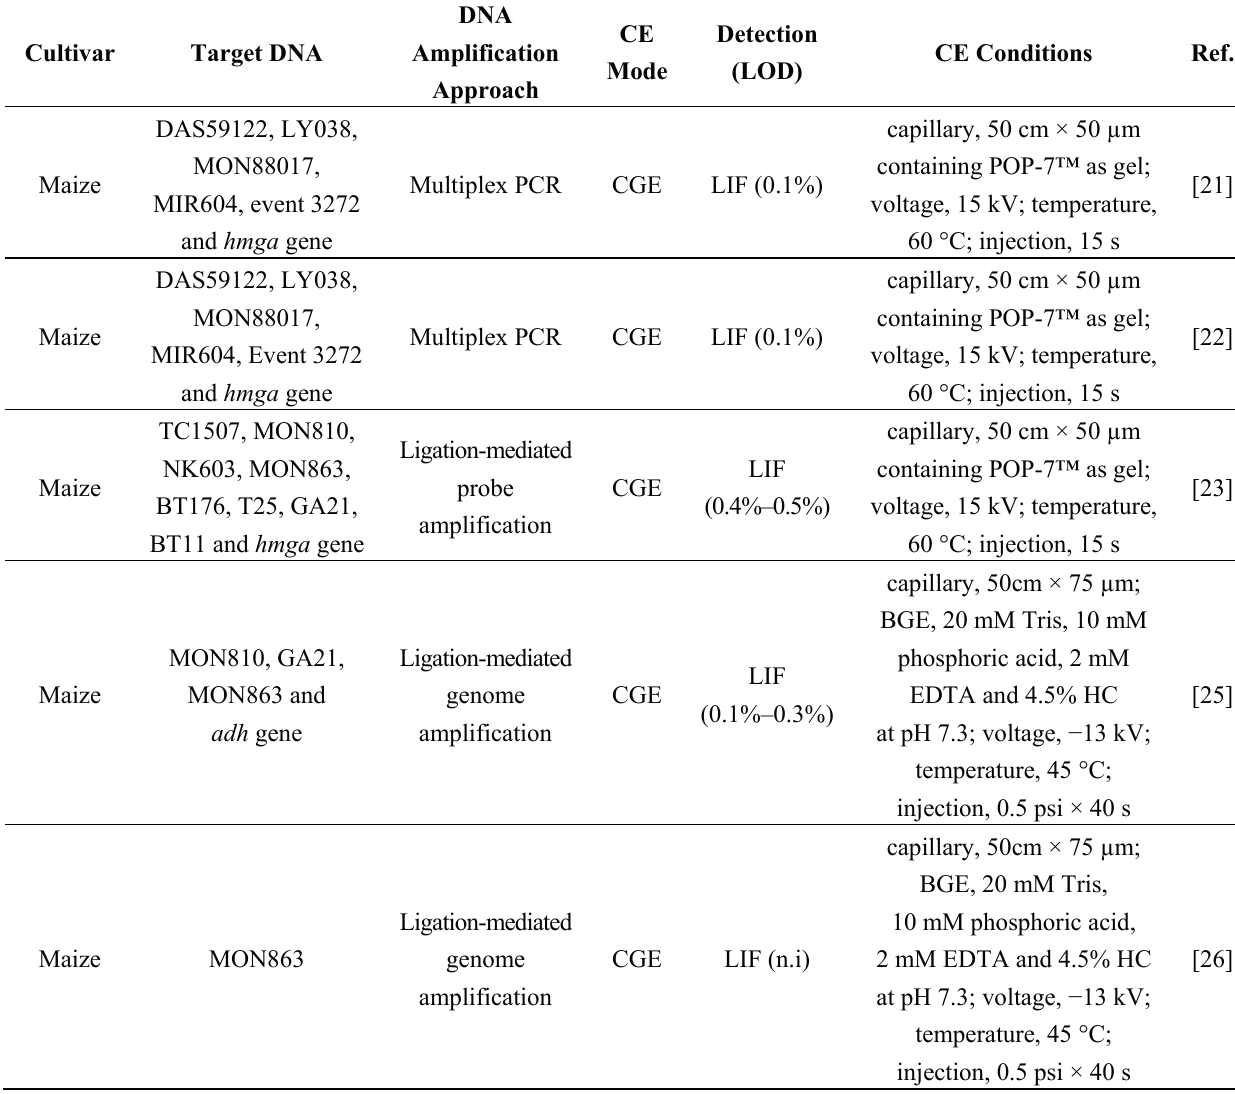
Table 1. Applications of capillary electrophoresis (CE) to the determination of DNA in transgenic